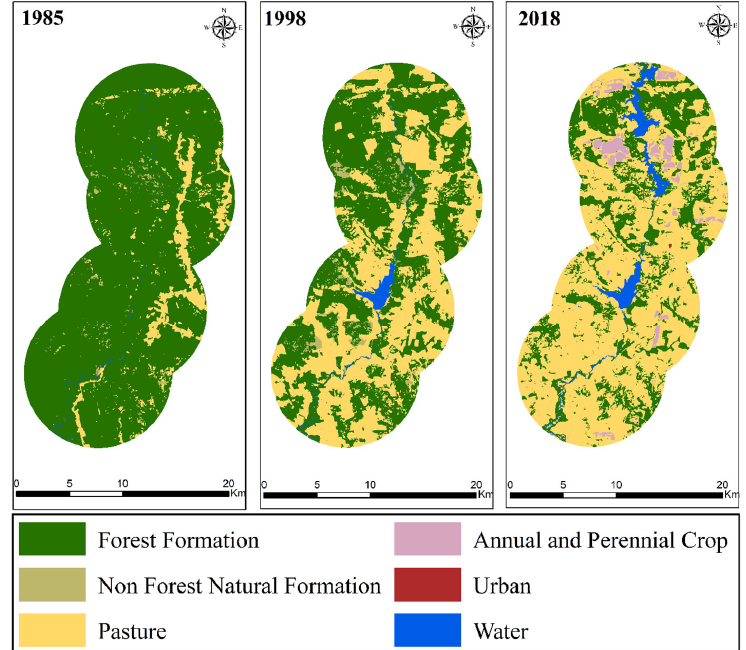
Figure 2. Land use and land cover in the direct influence zone of the Braço Norte Hydropower Complex representing the year when the construction began (1985), the filling of the reservoir (1998), and the current period (2018). Source: MapBiomas-Collection 4.1 level 3 dataset [25]. The variations derived from the LULCC process considering the years 1985, 1998, and 2018 are properly described in Figure 3.